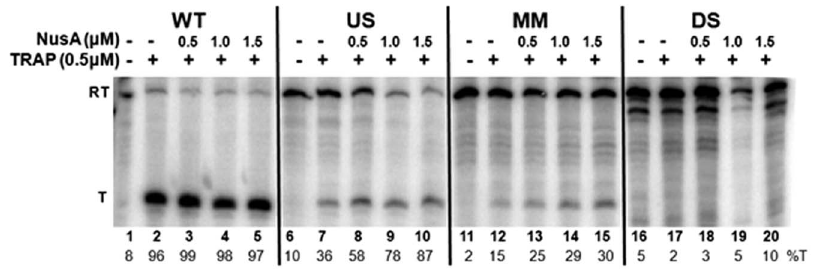
Figure 6. Effects of reduced NTP levels and of NusA on TRAP-mediated transcription termination in vitro . Polyacrylamide gel electrophoresis analysis of in vitro transcription of templates with the Wild Type (WT), U-stretch (US), mismatch stem (MM), and disrupted stem (DS) trp attenuator regions. Transcription reactions were performed in the absence or presence of 0.5 m M TRAP, and 0–1.5 m M NusA. The positions of read through (RT) and terminated (T) transcripts are indicated at the left. The percentage termination (%T) for each reaction is at the bottom of each